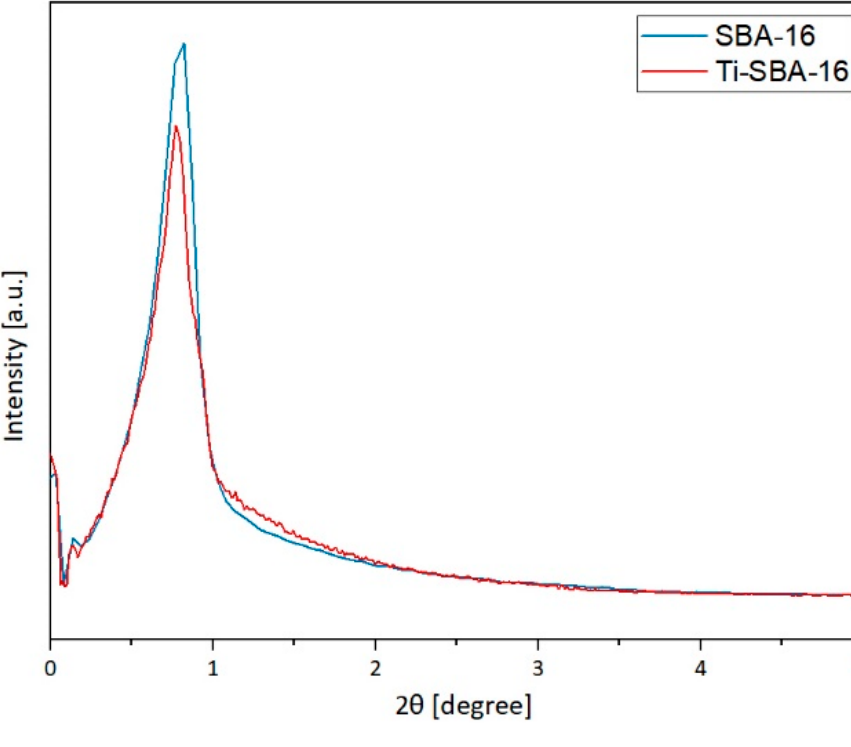
Figure 6. XRD (X-ray Di ff raction) patterns of the SBA-16 and Ti-SBA-16 Figure 6. XRD (X-Ray Diffraction) patterns of the SBA-16 and Ti-SBA-16 materials.